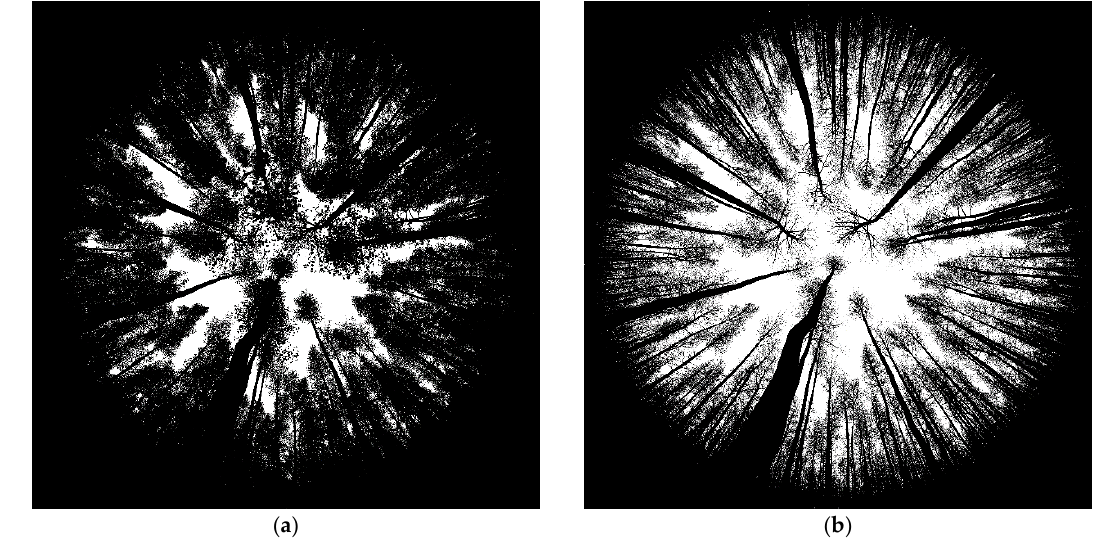
Figure 2. Two simulated binary DHP images generated at the same sampling point at leaf-on ( a ) and leaf-off ( b ) periods of a deciduous forest scene.